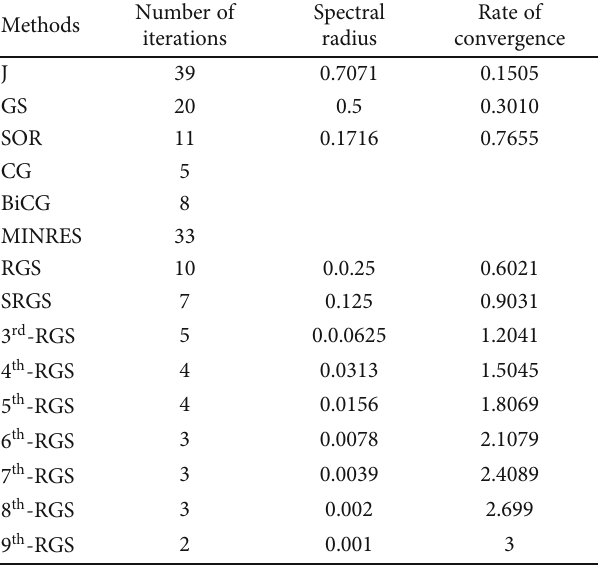
Table 2: Comparison of J, GS, SOR, and GRGS methods.